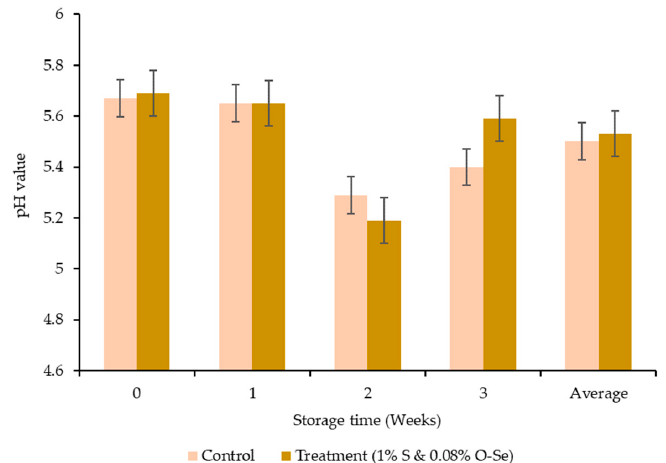
Figure 1. Effect of stevioside and organic selenium on the pH values in meats of Hanwoo cattle.